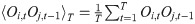
Observation scheme examples.In each scheme (the different rows) we observe two out of ten neurons in each time bin: (A,B) Fixed subset (C,D) Serial (E,F) Fully Random, (G,H) Random Blocks, and (I,J) double serial. Left (A,C,E,G,I): A sample of the observations O demonstrating the scanning method (a zero-one matrix, Eq 3). Right (B,D,F,H,J): empirical frequency of observed neuron pairs ⟨Oi,tOj,t−1⟩T=1T∑t=1TOi,tOj,t−1, with saturated colors to accentuate differences between methods (all values above 0.05 are shown in yellow). In the “fixed” scheme, some neurons are never observed. In the “serial” scheme some neuronal pairs are never observed. In all other schemes, all neuronal pairs are observed, so we can estimate the empirical moments using Eqs (16)–(17) and infer connectivity. In the two bottom schemes, observations are collected in persistent blocks, so neuron pairs which are close to the diagonal are observed more often.